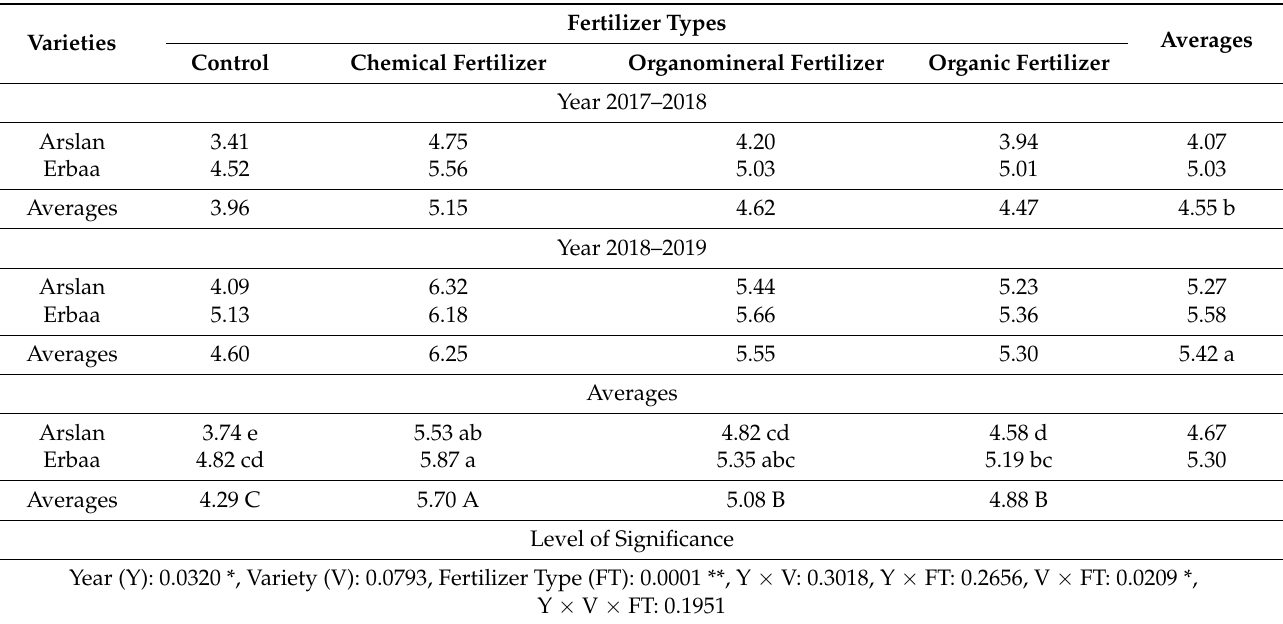
Table 6. Effect of fertilizer types on biological yield of coriander varieties (t ha − 1 ) 1 .